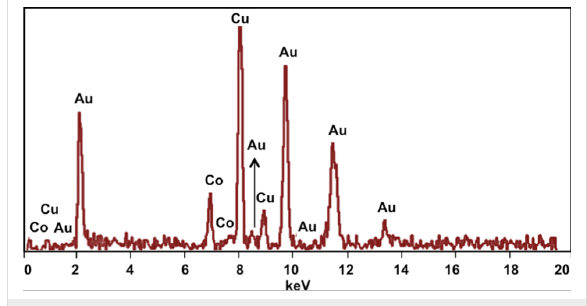
Figure 4: EDX spectrum of the Au@Co